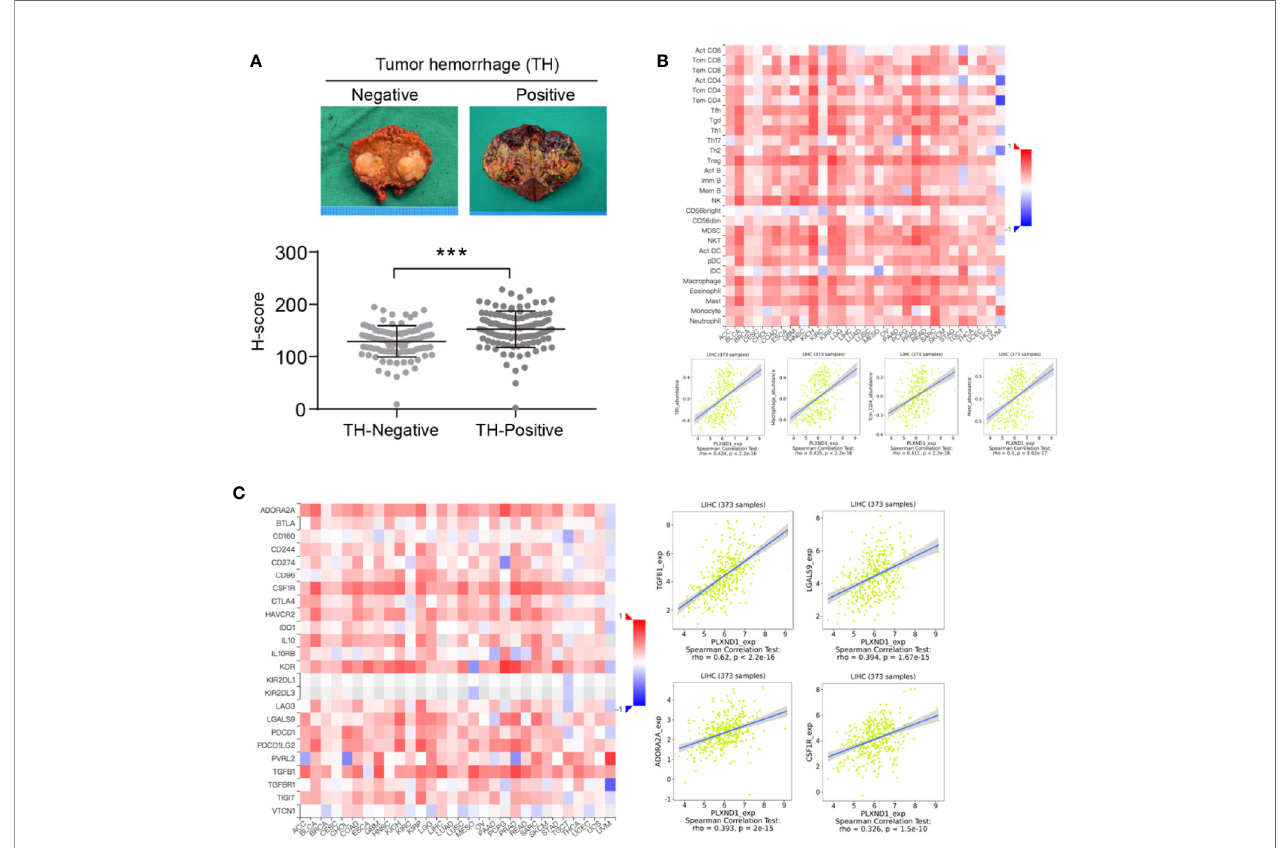
FIGURE 3 | The correlation of PLXND1 expression with tumor hemorrhage (TH), lymphocytes, and immunoinhibitors in hepatocellular carcinoma (HCC). (A) Increased expression of PLXND1 protein was found in TH-positive HCC compared with to TH-negative HCC. Representative gross specimens of HCC with/ without TH were also presented. (B) Upper panel: the correlation between PLXND1 expression and tumor-in fi ltrating lymphocytes (TILs) in pan-cancer; lower panel: in HCC, four TILs including Tfh cells, macrophages, Tcm_CD4 cells, and mast cells showed a kind of medium correlation with PLXND1 expression. (C) Left panel: the correlation between PLXND1 expression and immunoinhibitors in pan-cancer; right panel: in HCC, four immunoinhibitors was positively correlated with PLXND1 expression. TGF- b 1 showed a relative strong correlation with PLXND1 expression. ***P <